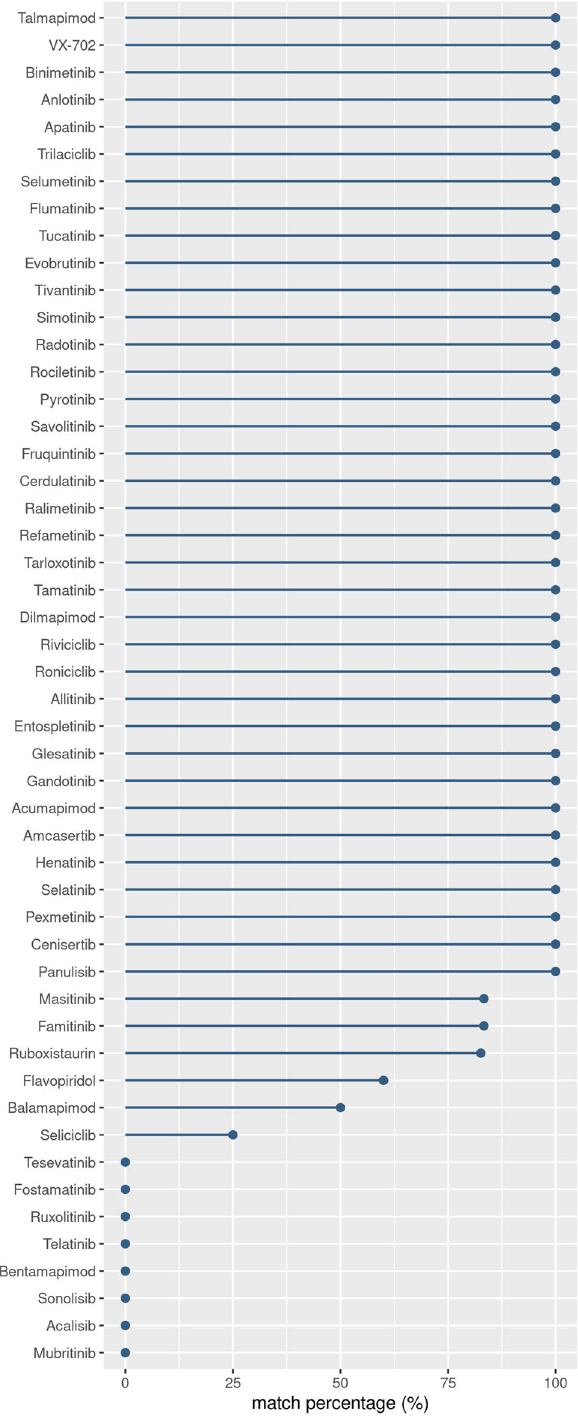
Figure 5. Validation results of the BMF1 on the known kinases inhibitors. PKIDB and MedChem Express datasets of kinase inhibitors were fed to the 84 BMF1 to validate their predictive potential. KUALA is able to correctly identify active inhibitors in 72% of